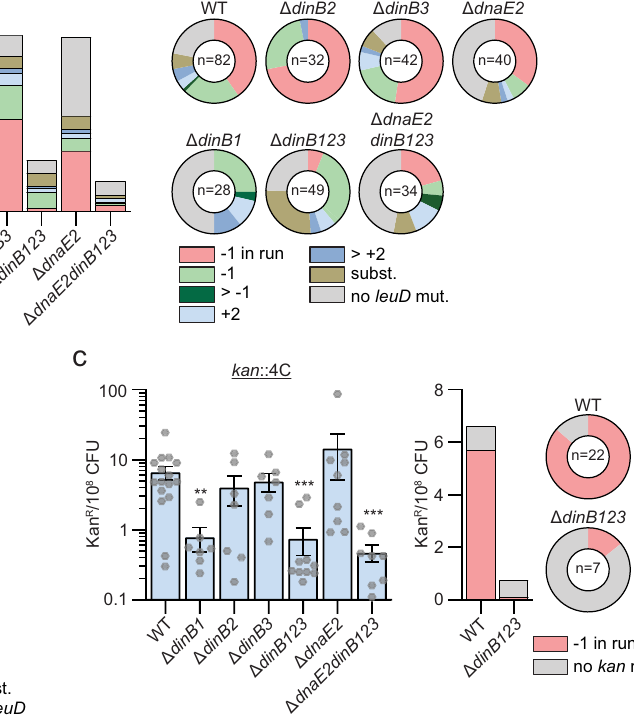
SEM) of data obtained from biological replicates symbolized by gray dots. Stars above bars mark a statistical difference with the reference strain (WT) and lines connecting two strains show a statistical difference between them (*, P <0.05; **, P <0.01;***, P <0.001).p-valueswereobtainedonlog-transformeddatabyone-way ANOVA with a Bonferroni